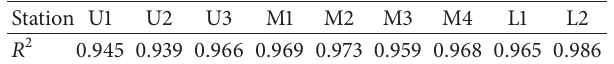
and ET 0 for pan